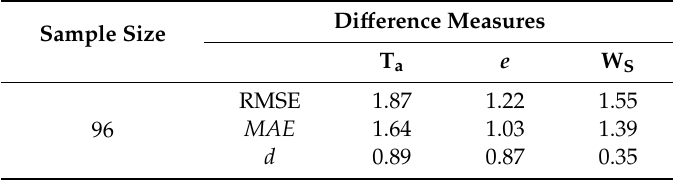
Table 5. Quantitative di ff erence metrics of modelled with respect to measured T a , e , W S for the four days of comparison (19th June, 1st July, 2nd July and 4th July